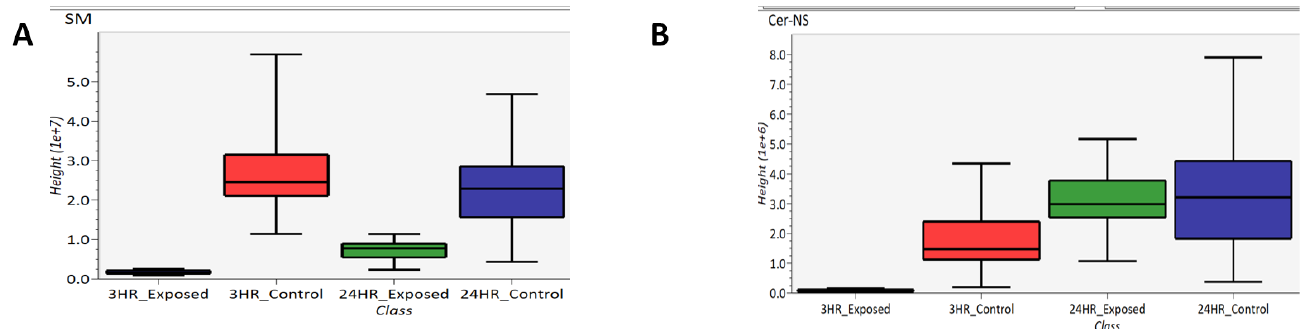
Figure 11. Box-and-whisker plots of ( A ) sphingomyelin and ( B ) ceramide.